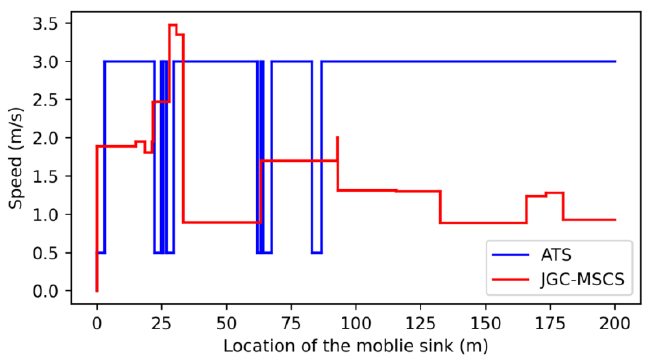
Figure 8. Comparison of the results of the MS speed controlling strategy of the proposed scheme of Figure 8. Speed of MS at di ff erent JGC-MSCS with the ATS scheme [20] .